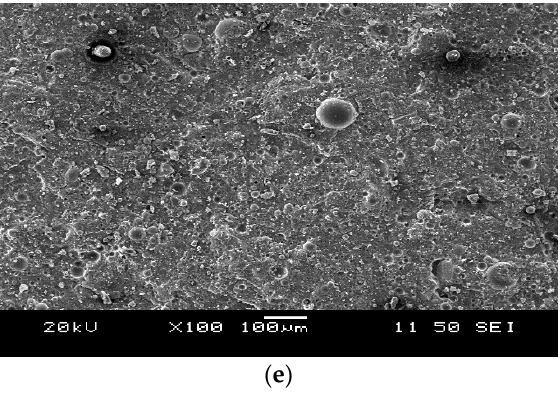
Figure 14. Morphology of binders at 28 days: ( a ) CS1, ( b ) CS2, ( c ) CFS1, ( d ) CFS2, ( e ) FP C .